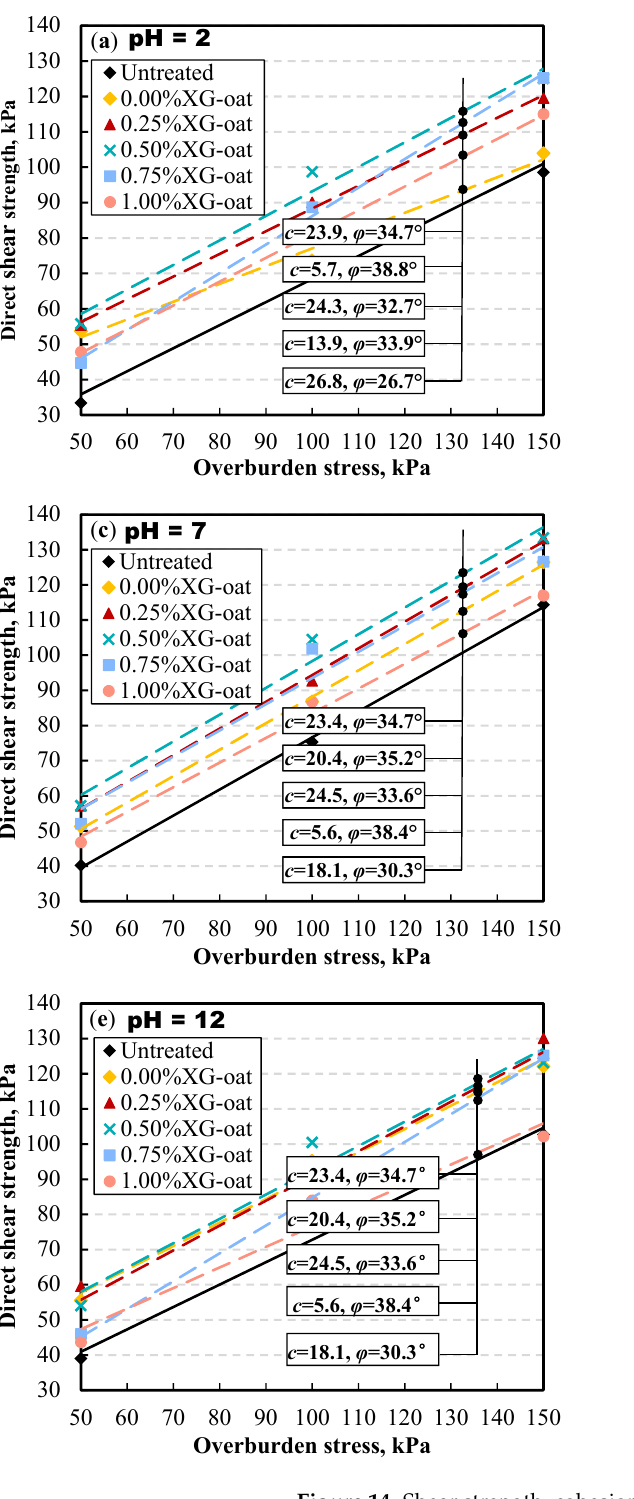
Figure 14. Shear strength, cohesion c , and internal friction angle ϕ with increasing XG contents un- der ( a ) pH = 2; ( b ) pH = 5; ( c ) pH = 7; ( d ) pH = 9; ( e ) pH = 12.